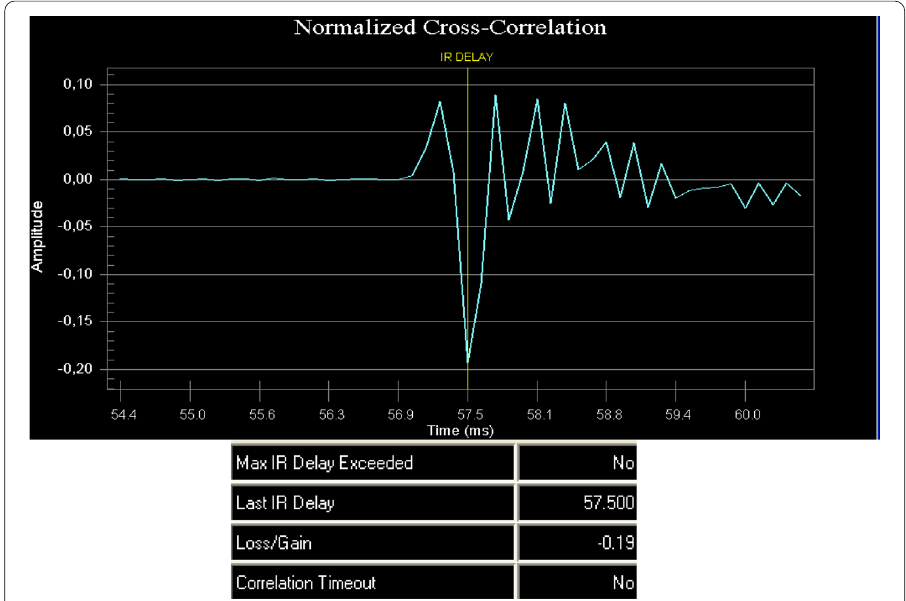
Fig. 15 Average delay from impulse response